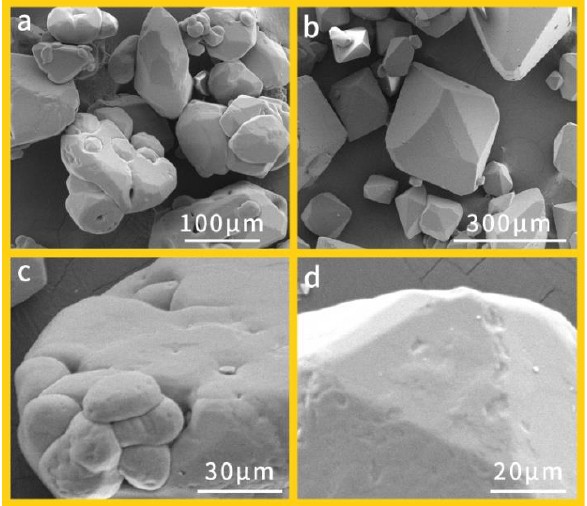
Figure 1. Apparent morphology images of different RDX crystals: ( a ) raw RDX (400 × ), ( b ) H-RDX (200×), ( c ) raw RDX (1500×), and ( d ) H-RDX (2000×).